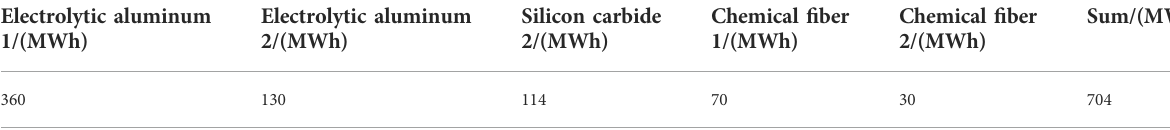
TABLE 4 Second round sequential auction adjustable electricity of controllable load enterprises.